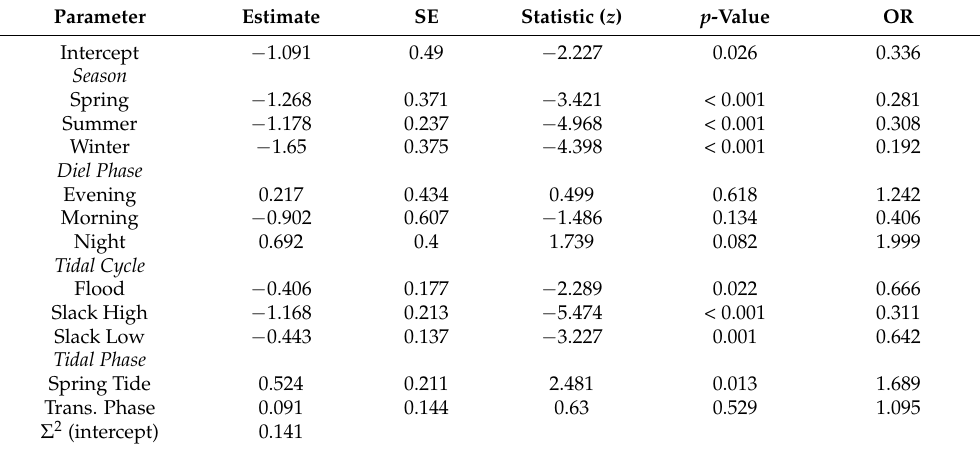
Table 4. Final model for Aughinish ( n = 3471 minICIs of which 437 classified as foraging. Recorded by 6 different C-POD units). Estimates with standard errors (SE) and odds ratios (OR) of the variables included in the model. Σ 2 is the variance of the intercept due to variability between C-PODs (C-POD ID as random